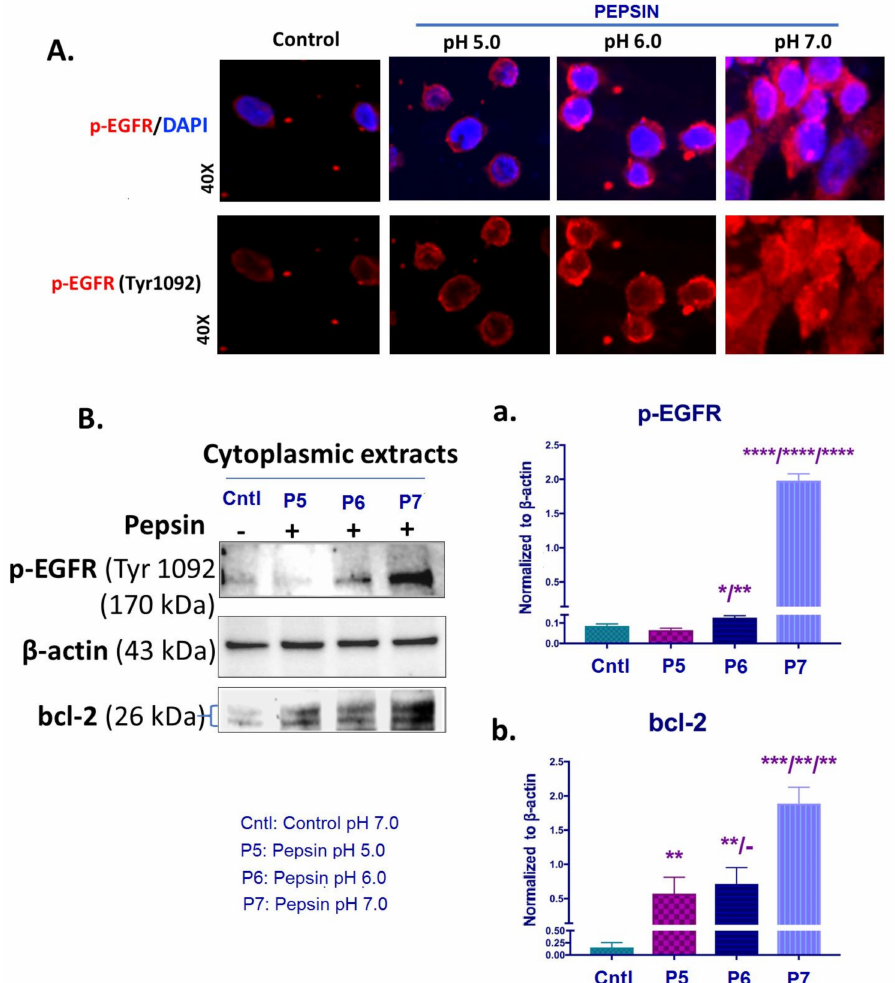
Figure 2. The pepsin-effect on EGFR activation and bcl-2 overexpression in HCs exposed to weakly acidic pH 5.0, slightly acidic pH 6.0 and neutral pH 7.0. ( A ) Immunofluorescence staining for p-EGFR (Tyr1092) (red: p-EGFR; blue: DAPI for nuclear DNA staining; scale bar 20 um by Zen imagining software). ( B ) Graphs depict the cytoplasmic protein levels of p-EGFR (Tyr1092) and bcl-2 ( a , b ) in pepsin and control-treated HCs, by western blot analysis ( β -actin was used to normalize cytoplasmic protein extracts) ( t -test; multiple comparisons by Holm-Sidak, * p < 0.05; ** p < 0.005; *** p < 0.0005; **** p < 0.00005; GraphPad Prism 7.0; means ± SD of three independent